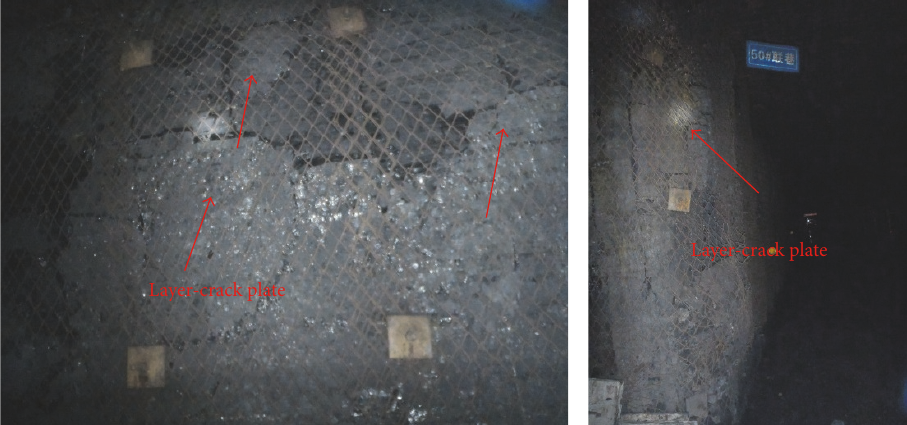
Figure 2: Layer-crack plate structure of the roadway coal